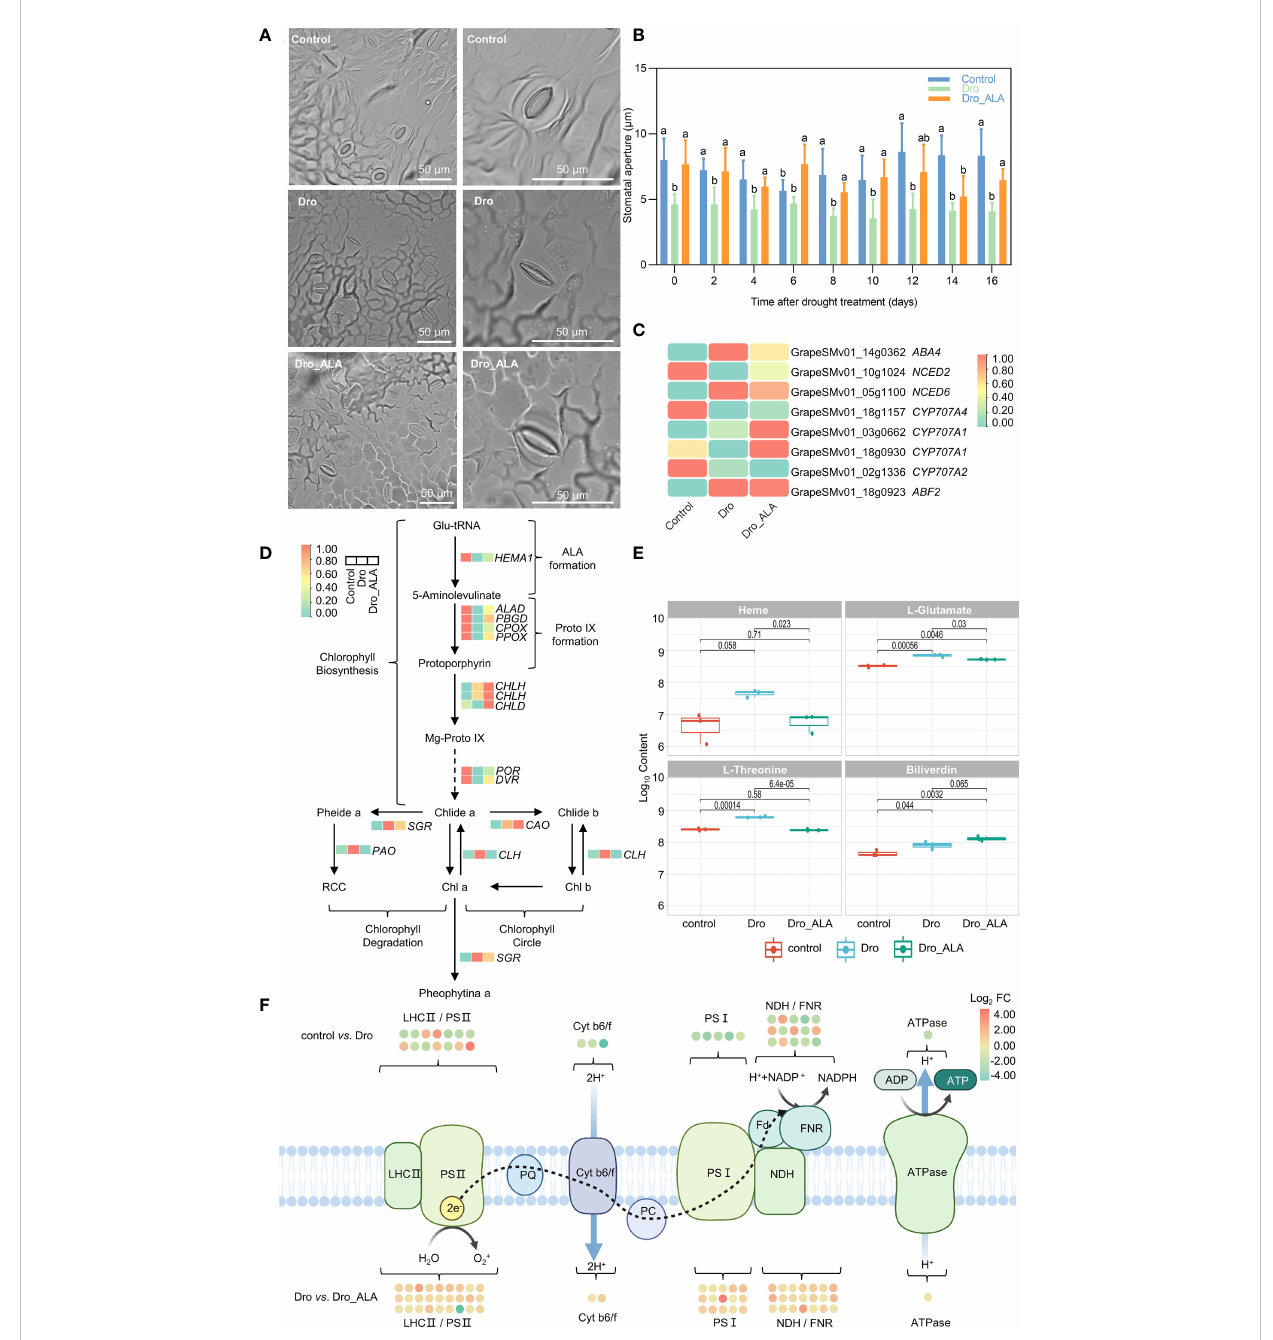
FIGURE 3 Stomatal movement, chlorophyll metabolism and photosynthesis in grapevine leaves under drought stress and drought plus ALA treatment. (A) Stomatal aperture observation of control, drought treatment (Dro), and drought plus 5-aminolevulinic acid treatment (Dro_ALA) on the 16 th day (via upright fl uorescent microscope). (B) Variation of stomatal aperture with drought treatment time. (C) Key DEGs related to phytohormones action between control vs. Dro, control vs. Dro_ALA, and Dro vs. Dro_ALA. (D) Pathway of chlorophyll metabolism and key genes in grapevine under drought stress and drought plus 5-aminolevulinic acid treatment. Arrows ( ↑ ) and ( ↓ ) indicate up-regulation and down-regulation, respective. Red indicates the control vs. Dro comparison group and blue indicates the Dro vs. Dro_ALA comparison group. (E) Key metabolites in chlorophyll metabolism pathway under control, Dro and Dro_ALA treatments. (F) Effects of drought and drought plus 5-aminolevulinic acid on photosynthesis. Each dots represents a DEG, green and red indicate up-regulation and down-regulation, respectively. Different letters indicate signi fi cant differences among experimental groups (p <